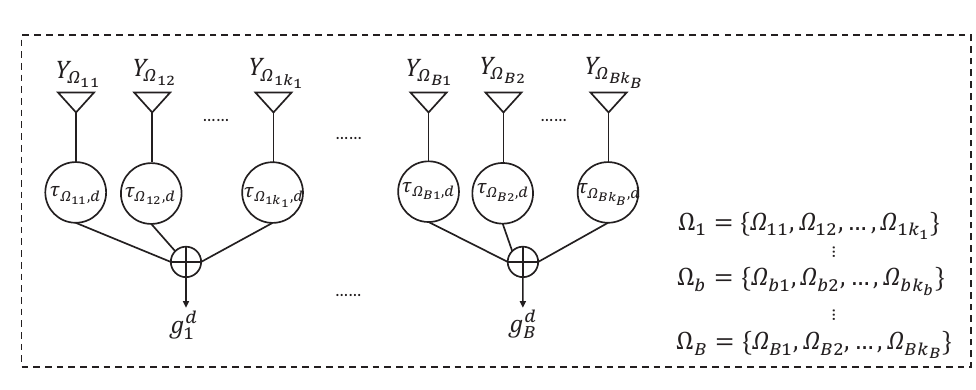
Figure 4. Block diagram of subarray